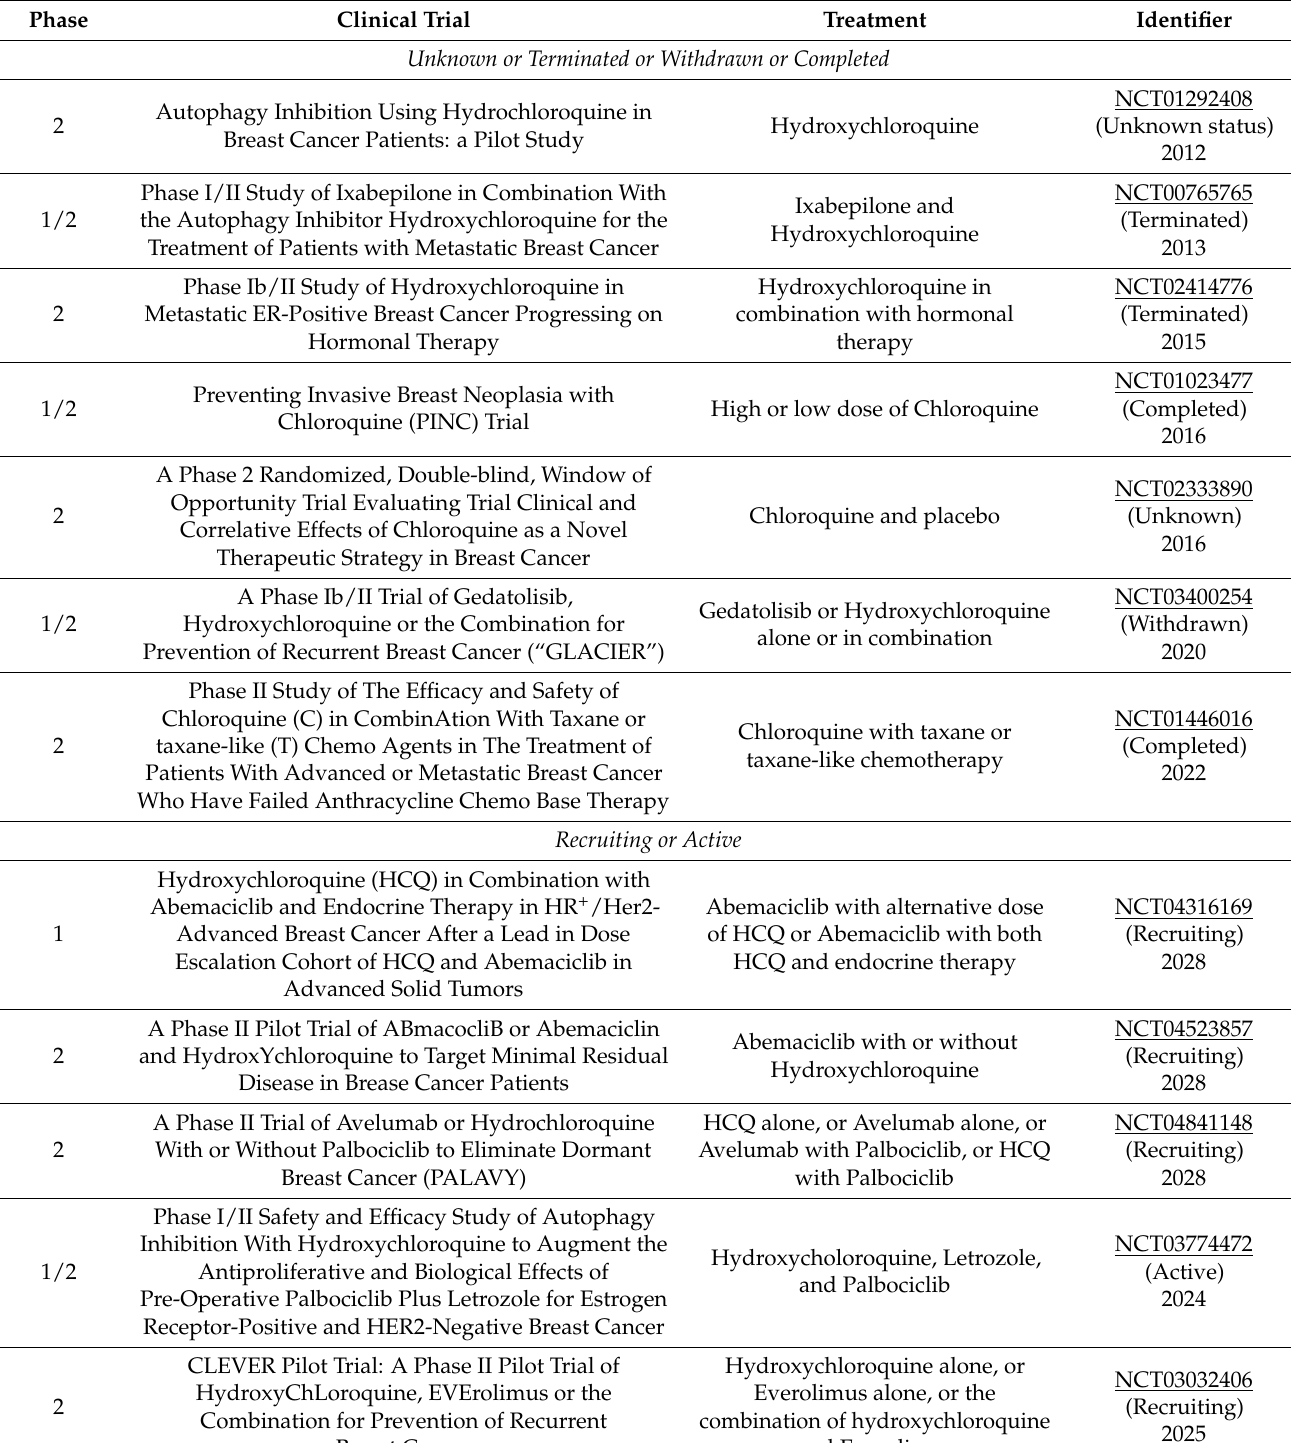
Table 1. List of all clinical trials of autophagy inhibitors in breast